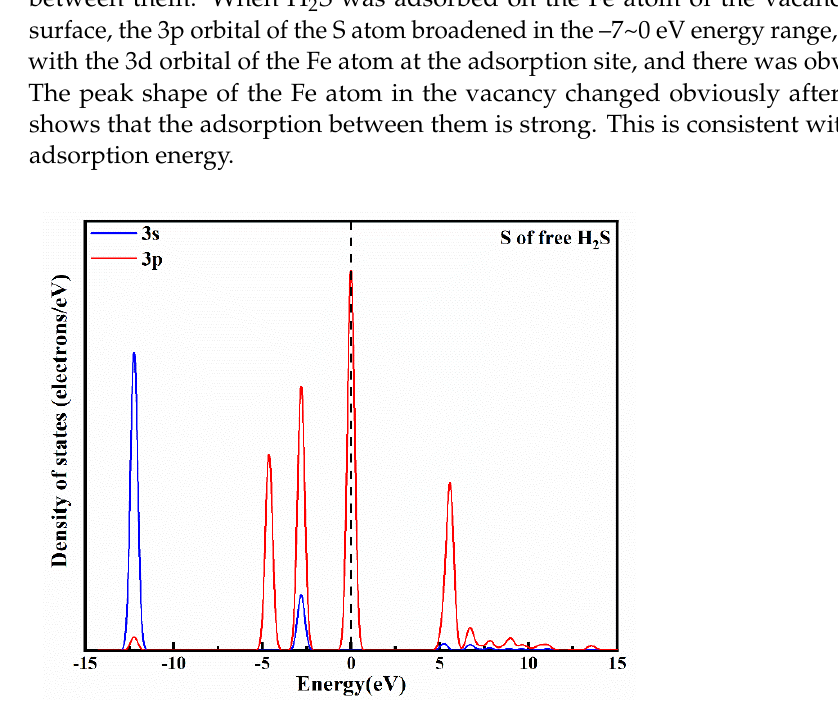
Figure 5. The PDOS of S atom in free H 2 S molecule.